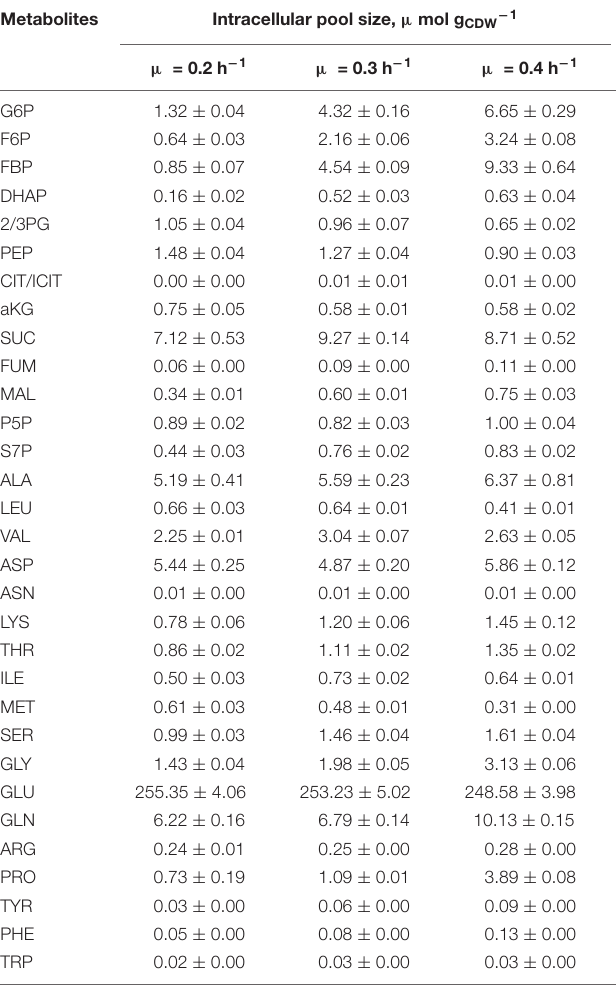
TABLE 2 | Biomass specific metabolite pool concentrations obtained with the fast-centrifugation treatment and hot-water-extraction from three biological replicates of C. glutamicum cultures cultivated in chemostat mode (processes A, B, C) at growth rates of 0.2, 0.3, and 0.4 h − 1 ( Figure 1 ). Metabolites